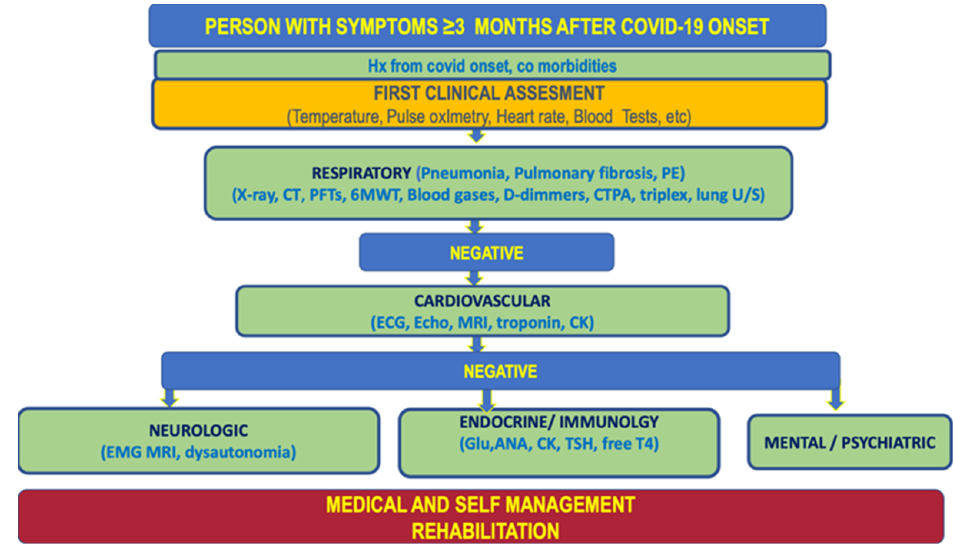
Figure 6. Proposed holistic approach diagnostic algorithm. PE: pulmonary embolism; Chest X-ray; CT: Computer Tomography; PFTs: Pulmonary Function Tests, 6MWT: six minute walking test, CTPA: Computer Tomography pulmonary angiogram, lung U/S ultrasound, ECG electrocardiogram, MRI: Magnetic resonance imaging, EMG: electromyogram, Glu: Glucose, ANA: Antinuclear antibodies, CK: creatine kinase, TSH: Thyroid-stimulating hormone Test, freeT4: Free thyroxine test.